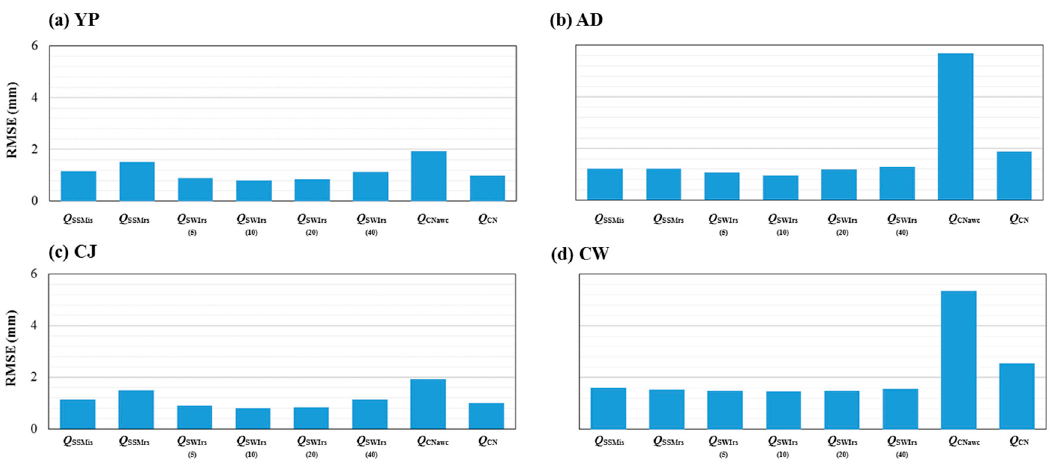
Figure 5. Comparative results of estimated runoff depths in the eight cases of RMSE at four sites: ( a ) YP; ( b ) AD; ( c ) CJ; and ( d ) CW.